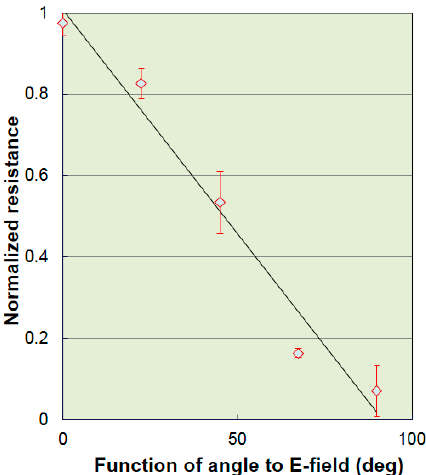
Figure 7. Relations of the function of E-field angle and normalized resistance with fiber angles in 24-ply CFRP laminates.